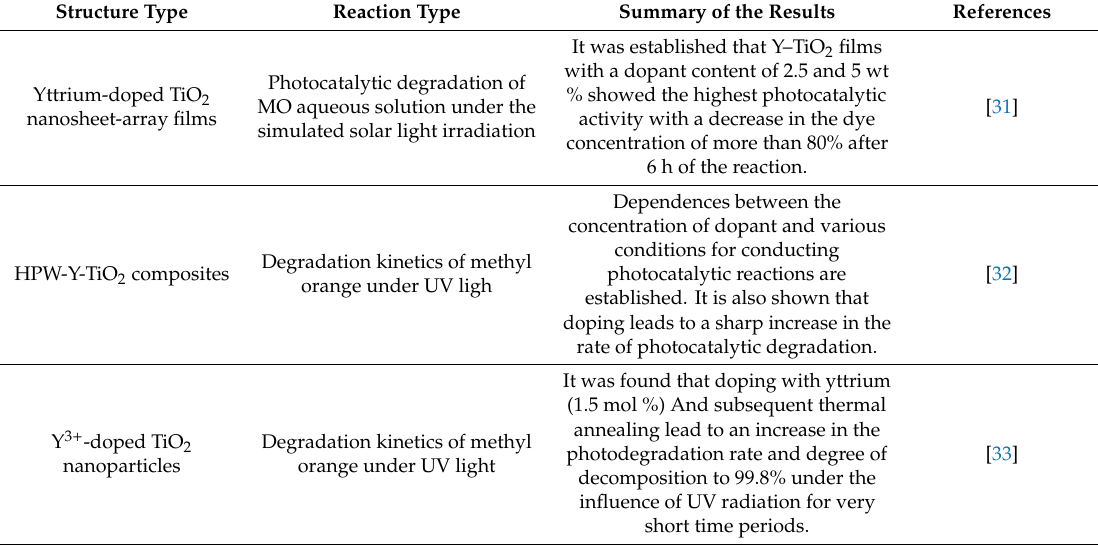
Table 3. Comparative analysis data